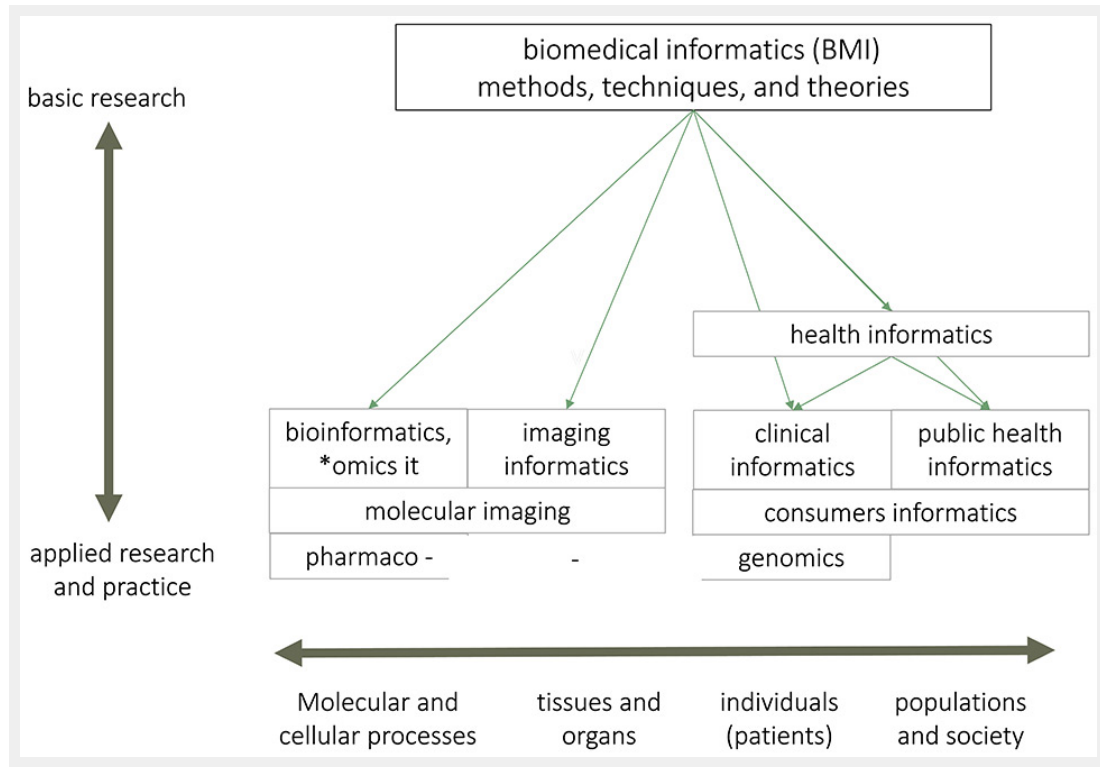
Figure 2 Biomedical informatics and its areas of application and practice. This figure, adapted from the International Medical Informatics Association publication on the definition of biomedical informatics [3], illustrates the umbrella relation between biomedical informatics and other related fields applying information sciences and technologies to